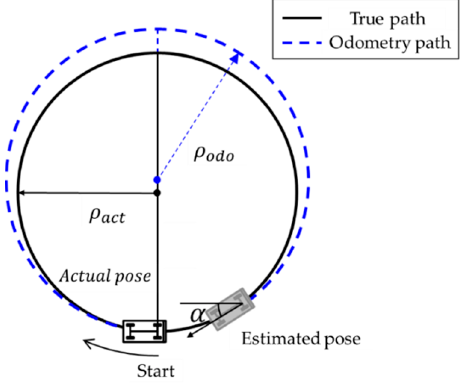
Figure 2. Comparing the actual path and odometry path with the wheelbase error.